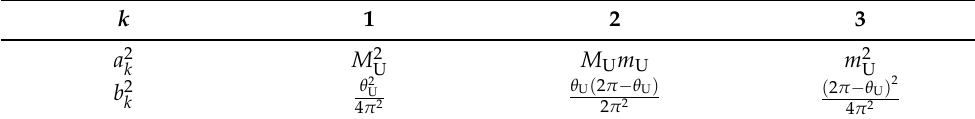
Table 2. Probability mass function of B i .